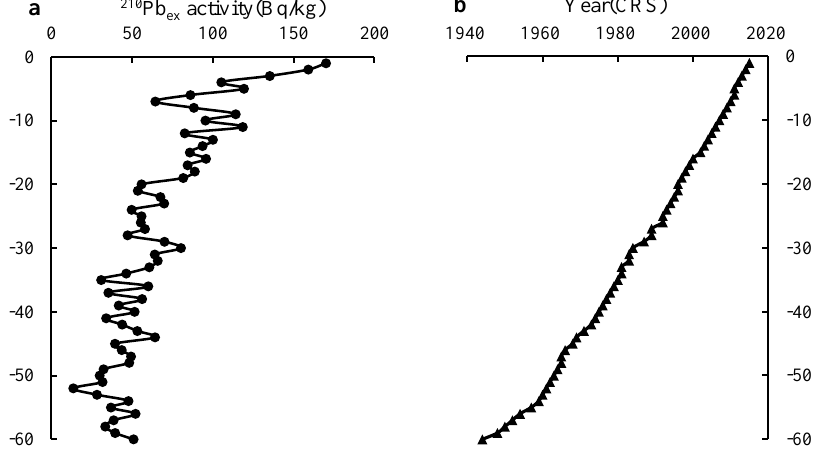
Figure 2. ( a ) Profile distributions of unsupported 210 Pb activity ( 210 Pb ex ) in the core SR3. ( b ) 210 Pb- derived chronology from the core SR3 in the Shuanglong